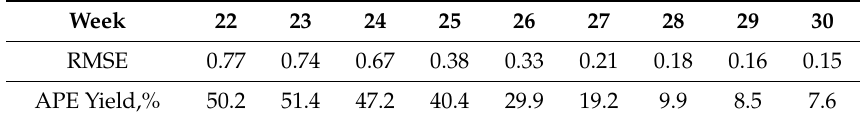
Table 9. Average RMSE and APE yield values, calculated using approximated NDVI maxima for 22 (June 1)–30 (July 30) calendar weeks in the Khabarovsk District (2010–2019).